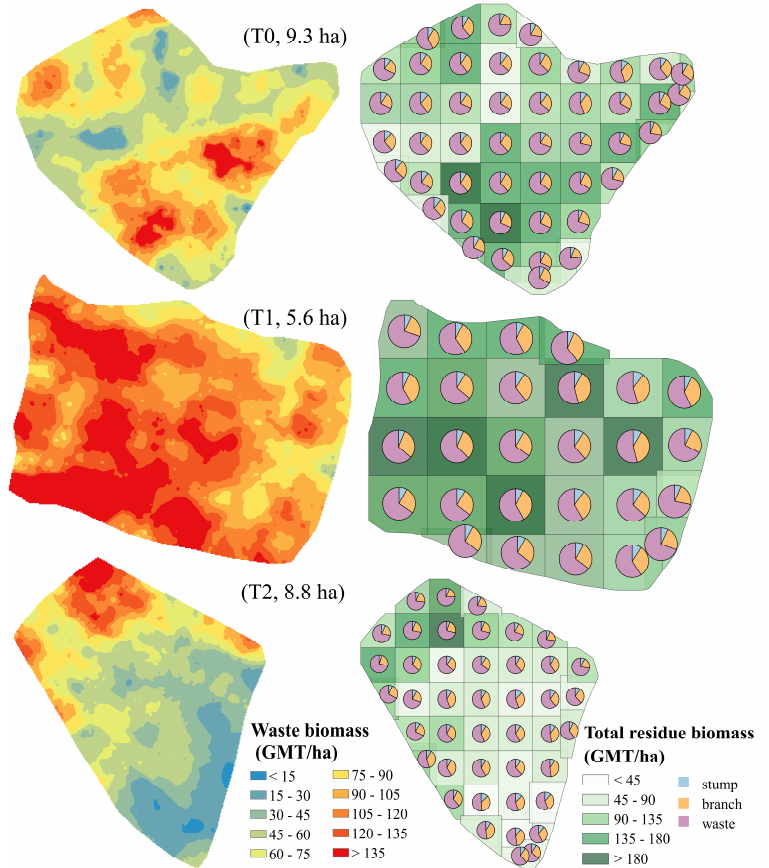
Figure 9. Heatmaps of waste biomass in green weight for three harvested areas representing T0, T1, and T2 plantations ( Left ). Grid cell maps of total harvest residue biomass in green weight and its proportional allocation to the three residue components ( Right ). The biomass quantities were calculated using the third method through harvester data analytics.